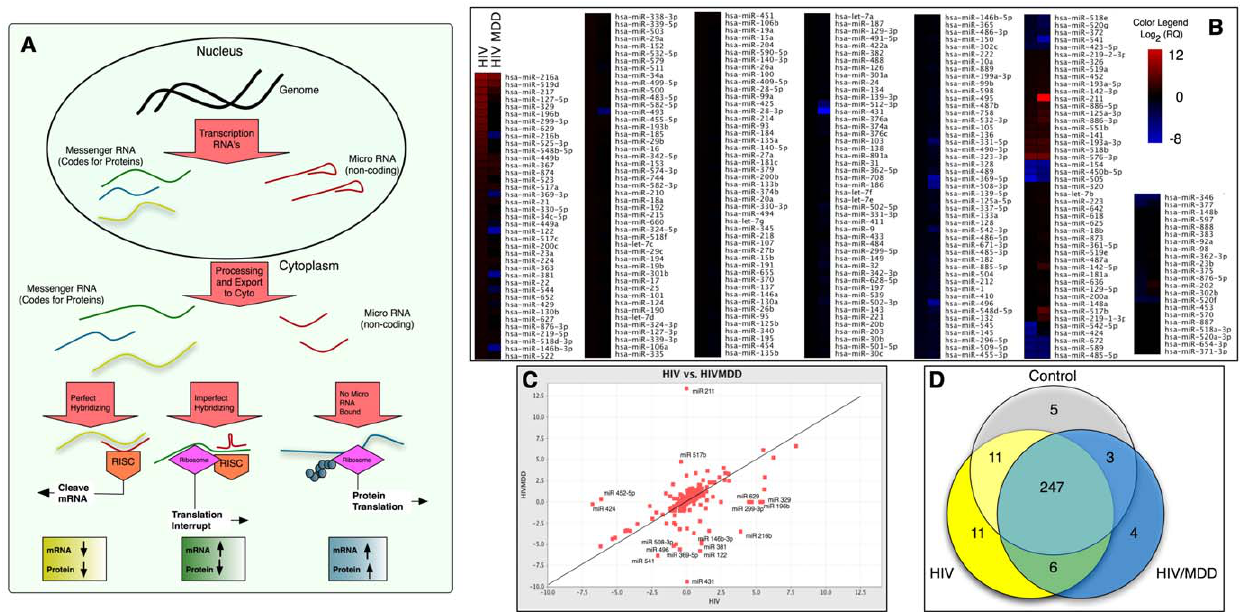
Figure 1. MicroRNA Profile of Frontal Cortex in HIV and HIV/MDD. (A) Summary of the biology of miRNAs. MiRNAs are synthesized in the nucleus and transported to the cytoplasm where they undergo processing by DROSHA and Dicer to mature miRNAs, which are presented by the RISC complex to hybridize to target sequences in the 3 9 UTR of mRNAs, where either translation is interrupted or mRNA is degraded. (B) Heat Map of miRNA Expression. While many miRNAs are not altered, a subset is upregulated and a smaller set downregulated in HIV. (C) MiRNA Expression of HIV vs HIV/MDD. Those whose expressions values fall on the x=y line would be contributed by HIV and those off of the line would presumably be related to MDD, more miRNA expression appears suppressed in the MDD context compared to HIV alone. (D) Venn Diagram of miRNAs expressed in the various groups. Supplementary Files S1 and S2 were used to generate (A) and (B) and can be manipulated using Gene Pattern software.